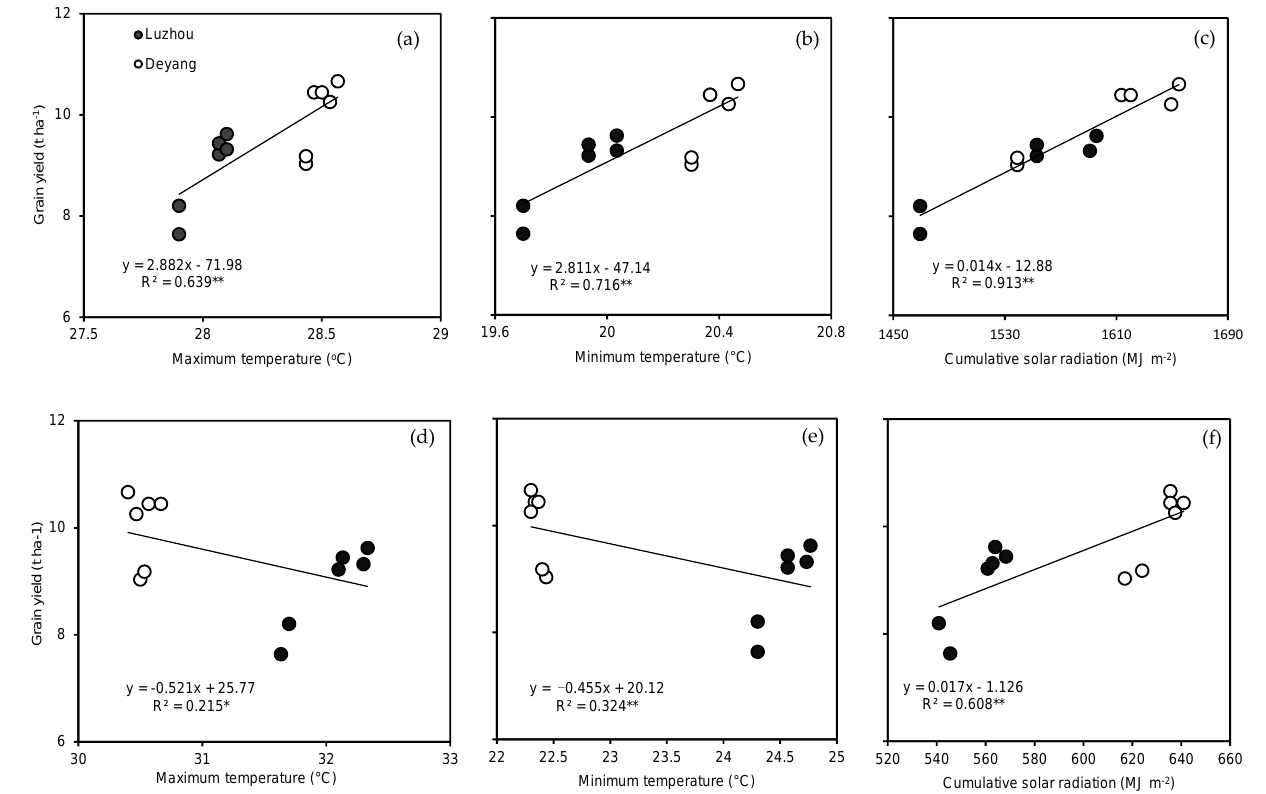
Figure 2. The relationships between grain yield and maximum temperature ( a ), minimum temperature ( c ), and cumulative solar radiation ( e ) from transplanting to heading, and maximum temperature ( b ), minimum temperature ( d ), and cumulative solar radiation ( f ) from heading to maturity of six rice cultivars at two locations from 2018 to 2020. Data are averaged across the three years of the field experiment. ‘*’ and ‘**’ denote significant relationships at the 0.05 and 0.01 probability levels, respectively.